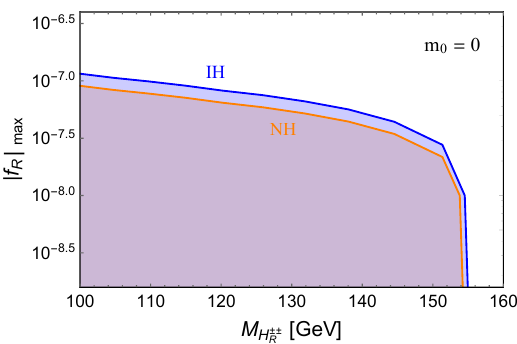
Figure 16 . Limits on M in the LRSM and its largest Yukawa coupling j f R j max from searches H (cid:6)(cid:6) R of doubly-charged HSCPs by the CMS group [102]. The orange and blue regions are excluded respectively for the NH and IH cases with the lightest neutrino mass m 0 = 0.